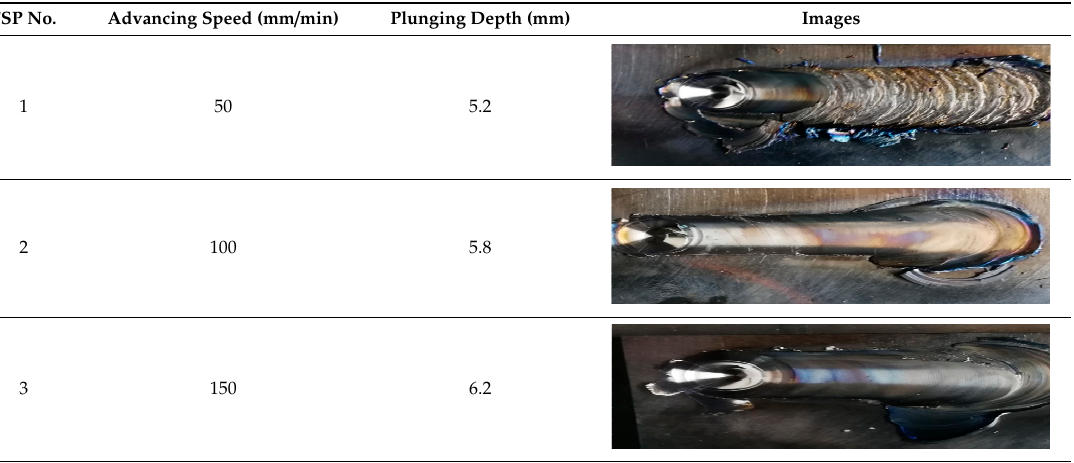
Figure 2. RM-1 friction stir welder and FSP tool: ( a ) friction stir welder, ( b ) tool profile. There are various ways to optimize FSP, such as focused on surface quality (the presence of defects and smoothness), grain refinement, etc. In this research work, the optimization was based on the surface quality. FSP was performed on a 2507 SDSS plate of 6.5 mm thickness using three different parameters, as listed in Table 2. These processes were performed under position control. All FSPs were performed with an argon shield (see Figure 2a) and along the rolling direction of the plate. Rotational speed and tilt angle were kept constant at 400 rpm and 2°, respectively. The parameters of FSP No. 2 that resulted in the best surface quality (see Table 2) were selected for further processing. Table 2. FSP parameters and images for optimization of the process.